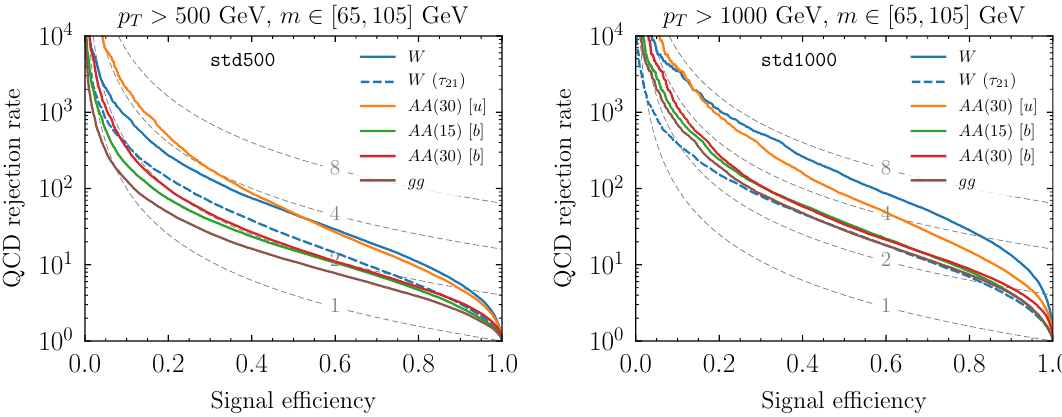
Figure 1 . Signal e(cid:14)ciency versus background rejection for the anti-QCD std500 (left) and std1000 (right) taggers. Signi(cid:12)cance improvement due to shape-variable tagging is indicated by the dashed grey contours. Also indicated is the e(cid:14)ciency curve for (cid:28) (1) for hadronic W decay (dashed 21